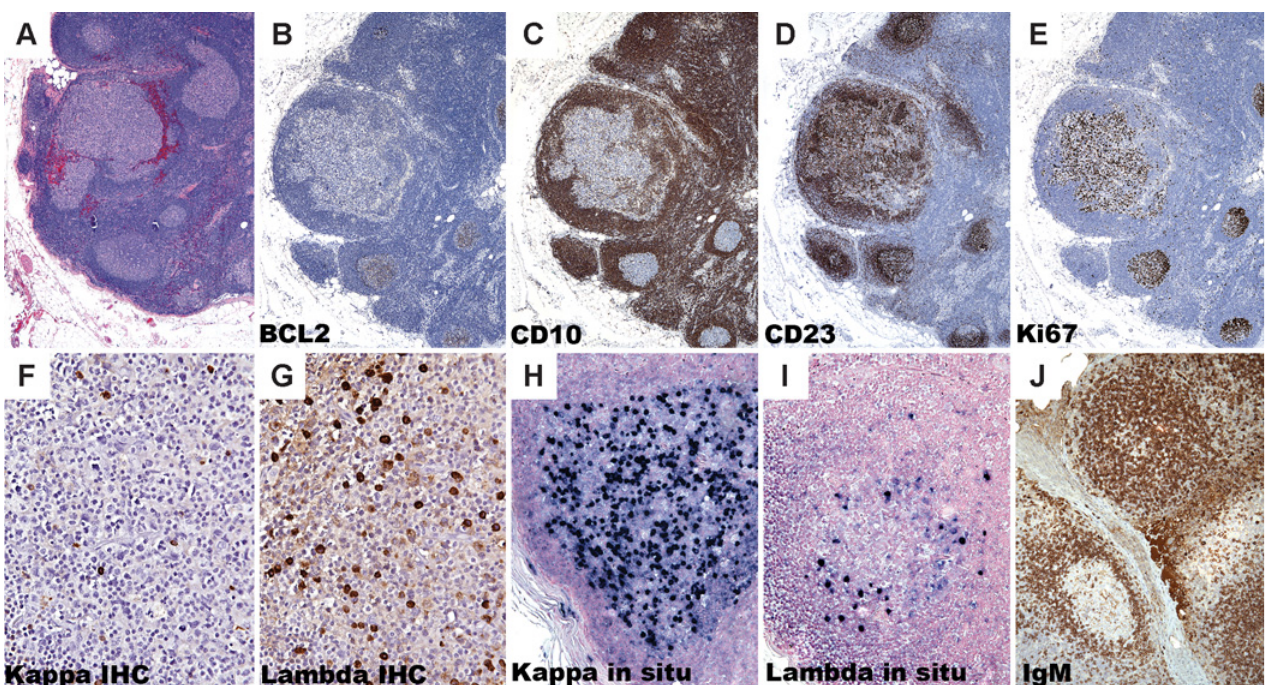
Fig 2. Immunohistochemistry of isolated atypical follicles. An axillary lymph node dissection in a 58 year-old woman with breast carcinoma (case 3) shows a lymph node with a cluster of follicles (A). BCL2 expression is absent in both the involved and uninvolved follicles (B) and the involved follicle shows diminished CD10 expression relative to the surrounding normal germinal centers (C). CD23 demonstrates an intact follicular dendritic network around the involved follicle (D). Ki-67 is polarized in surrounding reactive follicles, but is not polarized in the involved follicles (E). The involved follicle in case 1 shows lambda light chain-restricted B-cells (F and G). Case 2 shows highly atypical large cells that by situ hybridization (ISH) for immunoglobulin kappa and lambda light chains show kappa-specific RNA in the majority of the atypical cells, confirming light chain restriction in the involved follicle (H and I). A periaortic lymph node from a 53-year old woman (case 4) shows abnormal strong IgM protein expression in the centroblasts of an involved follicle whereas the uninvolved follicle shows a weak dendritic pattern of IgM reactivity, which is typically seen in normal follicles